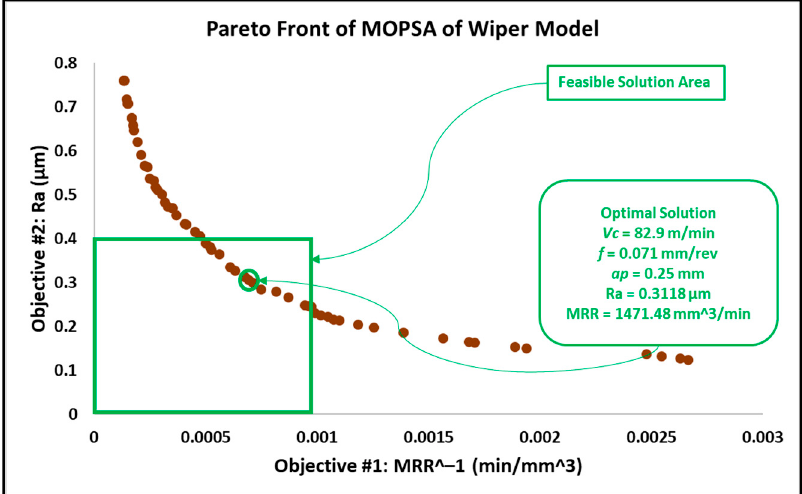
Figure 9. Pareto front plot of MOPSA solution of the wiper model.